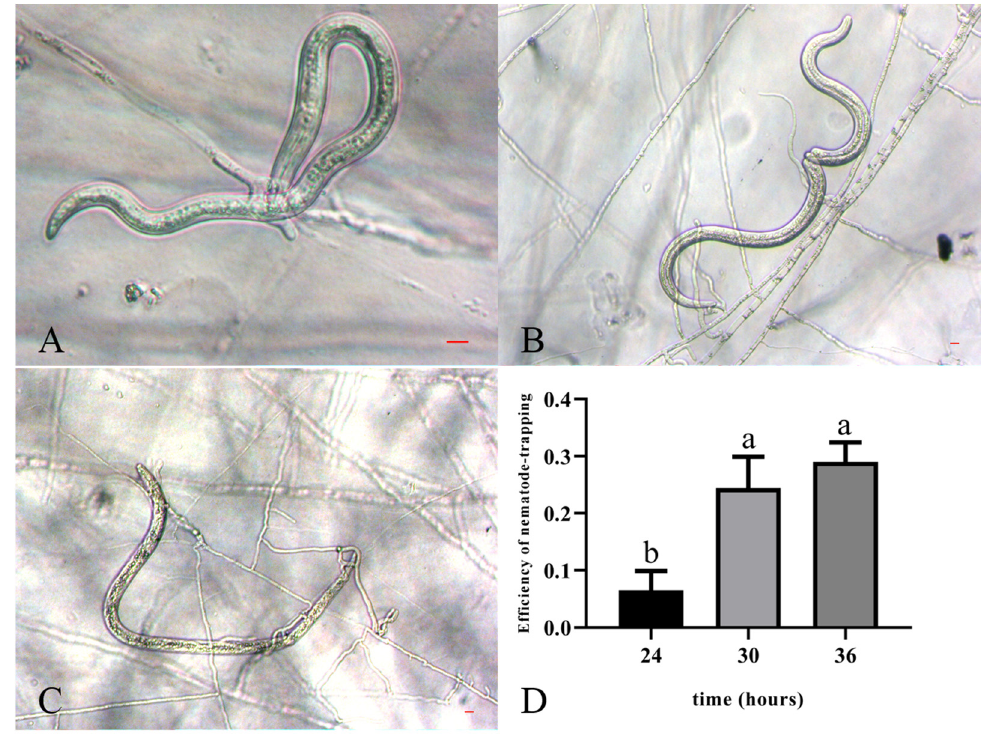
Figure 2. Trapping process of PWNs exposed to A. robusta . ( A ) The formation of the trap when PWNs were exposed to A. robusta for 24 h. ( B ) The trap’s contraction when PWNs were exposed to A. robusta for 30 h. ( C ) The increase in the size of the trap when PWNs were exposed to A. robusta for 36 h. Bar = 10 μ m. ( D ) Nematode-trapping efficiency of PWNs exposed to A. robusta .